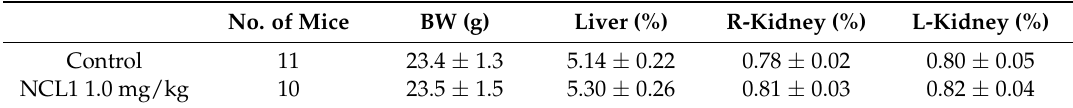
Table 1. Relative organ weights at the experiment’s termination in a PCai1 mouse tumor model. BW: body weight; R: right; L: